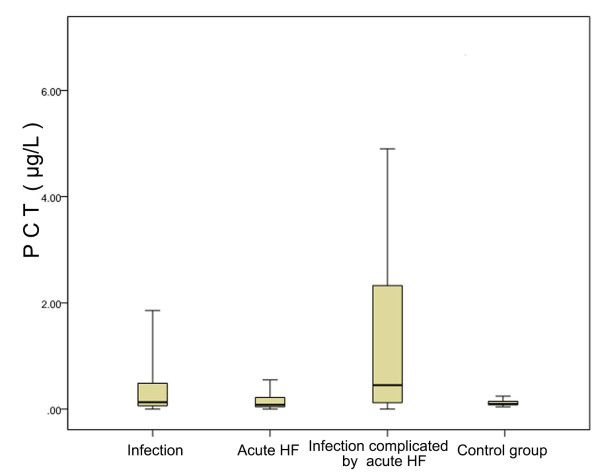
Differential expression of procalcitonin in different populations. HF, Heart failure; PCT, Procalcitonin. Boxes represent interquartile range, while whiskers the 5th and 95th percentiles in each category.